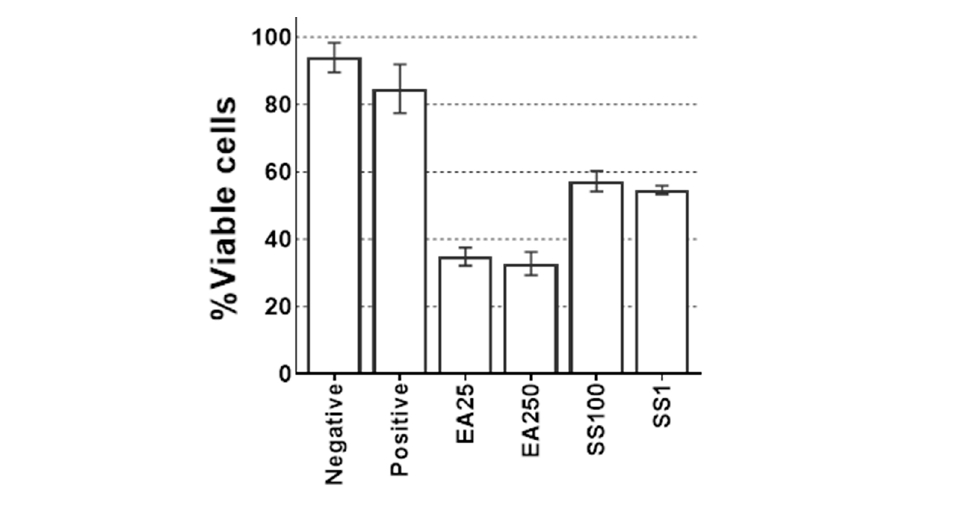
Figure 2. Cell viability of cultures encysting with GST inhibitors. Values represent percentage of cell viability. Negative control was used as a regular culture with AX2. The positive control is the encysting culture with NEM. EA25: Ethacrynic acid 25 µM. EA250: Ethacrynic acid 250 µM. SS100: Sulfosalazine 100 µM. SS1: Sulfosalazine 1 mM. Error bars represent the standard error of the mean.